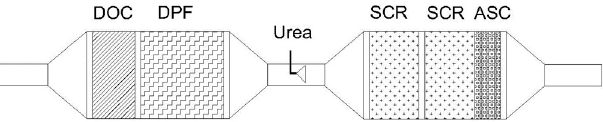
Figure 1. A typical advanced emission control system in diesel vehicles.